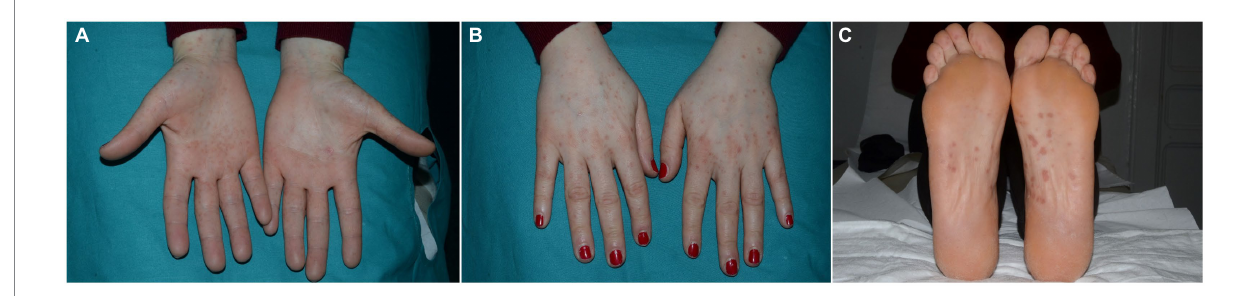
FIGURE 4 Erythematous maculopapular eruption limited to the palmar (A-B) and plantar (C)